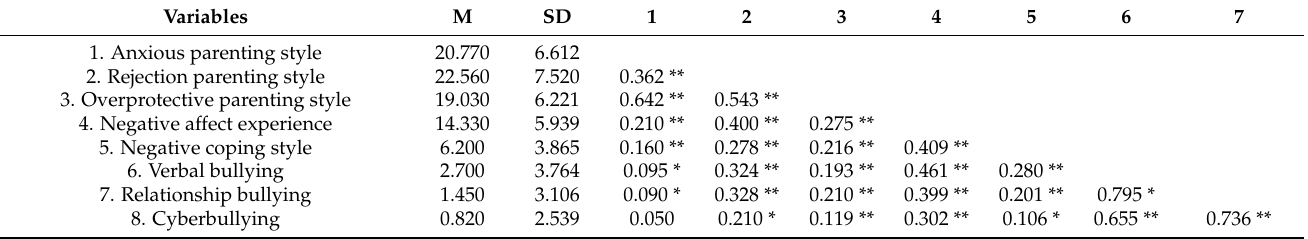
Table 3. Descriptive statistics and correlation matrix for all variables (N =